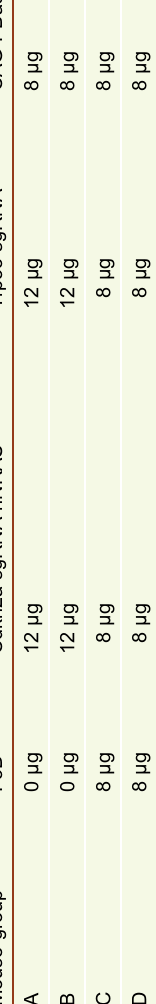
Figure 1. TMP-inducible DD-Cas9 constructs . (A) Schematic of the DD-Cas9 strategy. DD-Cas9 is inactive (degraded) in the absence of a cell-permeable small molecule trimethoprim (TMP), and is active (fully functional) in the presence of TMP. (B) DD-Cas9 variants. Top row, the constitutive wild-type Cas9 expression plasmid S9, which contains a CBh promoter, a Flag tag, two NLSs joined to Cas9 enzyme. Other rows represent fi ve DD-Cas9 variants with distinct con fi gurations of Flag tag, DD, and Cas9 with their abbreviations on the left. PB3 and PB5, terminals of the piggyBac transposon; pA, polyadenylation signal. (C) Representative T7EI cleavage assay of DD-Cas9 variants at TET1 locus. In HeLa cells, the editing activity of these DD-Cas9 variants was evaluated with and without 1 μ mol/L TMP treatment for 5 days. Red asterisks indicate the expected T7EI-speci fi c cleavage bands. Relative indel frequencies (%) were illustrated at the bottom line. L, 1 kb plus DNA ladder; NT, non-transfected group. (D) Bar charts illustrated the targeting ef fi ciencies of TET1 , TET2 , TET3 by T7E1 assay in the absence or presence of TMP. F5D was tightly controlled by TMP and displayed signi fi cantly higher activity across all three targeted genes. Data indicate the means ± SD of three biological replicates (* P < 0.05, ** P < 0.01, *** P < 0.001, Student ’ s t -test). (E) Determination of the optimal TMP working concentration of F5D. HeLa cells expressing F5D were exposed to TMP with increasing concentrations for 5 days. The Cas9 protein levels were analyzed by Western blot with an anti-Flag antibody (top). β -Tubulin was used as a loading control. The corresponding protein levels were quanti fi ed using the ImageJ software, and the indicated ratios were graphed (bottom). The results show that Cas9 protein level reaches a plateau at 1 μ mol/L TMP. Data indicate the means ± SEM of three independent experiments. (F) Kinetics of DD mediated Cas9 protein degradation. Western blot analysis was performed for DD-Cas9 proteins obtained from continuous TMP (1 μ mol/L) exposure (up to 72 h) or withdrawal after 2 h TMP treatment at indicated time points (top). The indicated ratios were graphed (bottom). Data indicate the means ± SEM of three independent